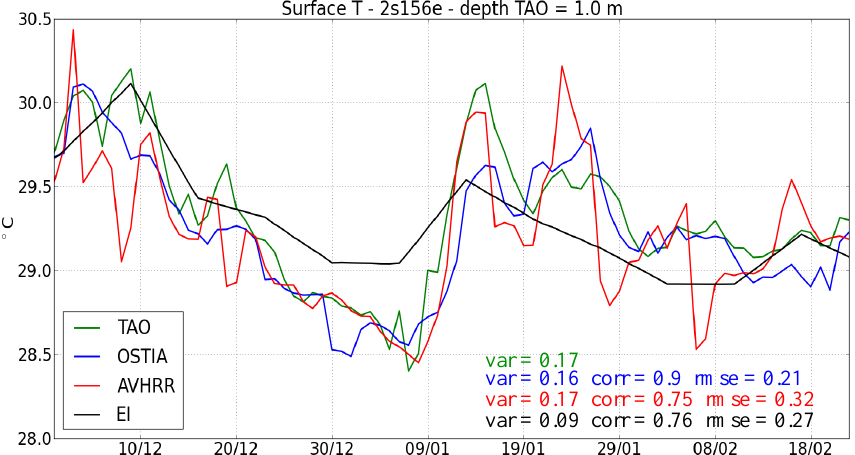
Fig. 3. In-situ SST (temperature observed at 1m depth, TAO, green line), OSTIA SST (OSTIA, blue line), AVHRR SST (AVHRR, red line) ERAi SST (EI, black line) at the TAO station 2 ◦ S–156 ◦ E from December 1992 to March 1993. SST in ◦ C. On the background is written the variance (var) associated to each SST product. For the OSTIA, AVHRR and ERAi SST, the correlation (corr) and the root mean square error (rmse) with respect to the TAO SST are also provided.